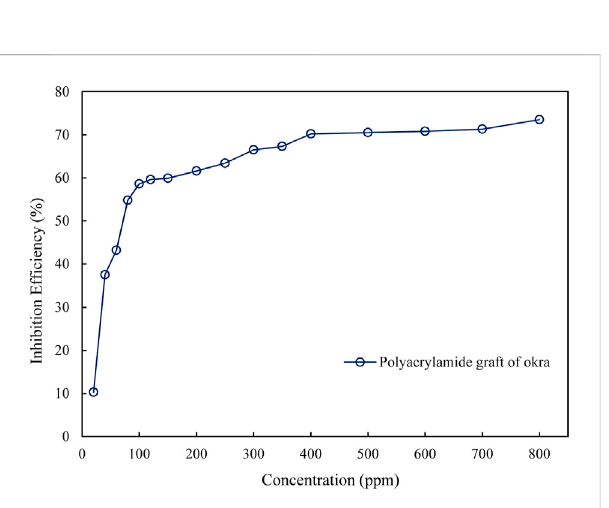
FIGURE 3 Comparison of, I.E., performance of okra mucilage powder and polyacrylamide-okra graft at 25 ° C for 24